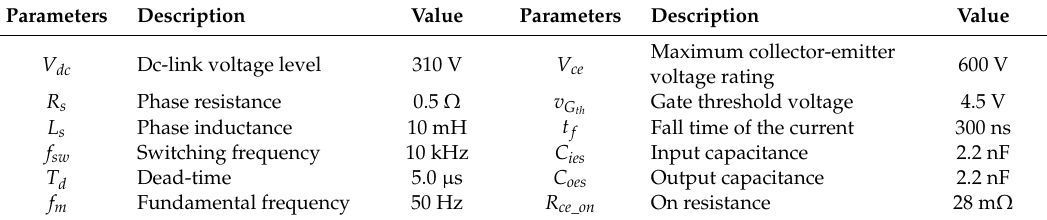
Table 3. The specifications of the simulation.